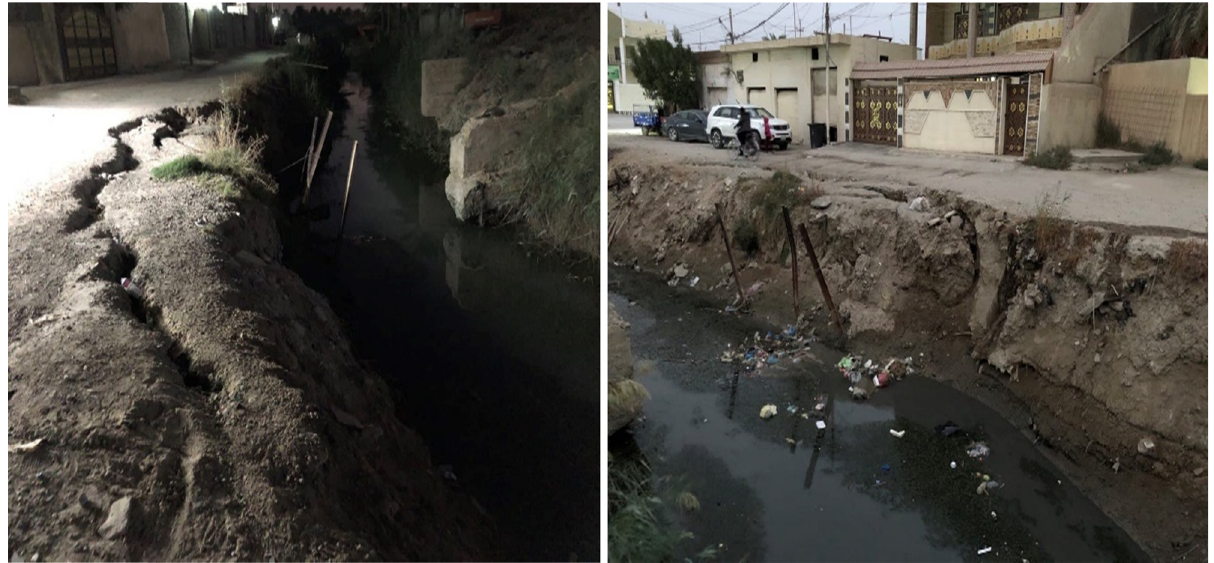
Figure 13: Birmana earth canal ( case study )